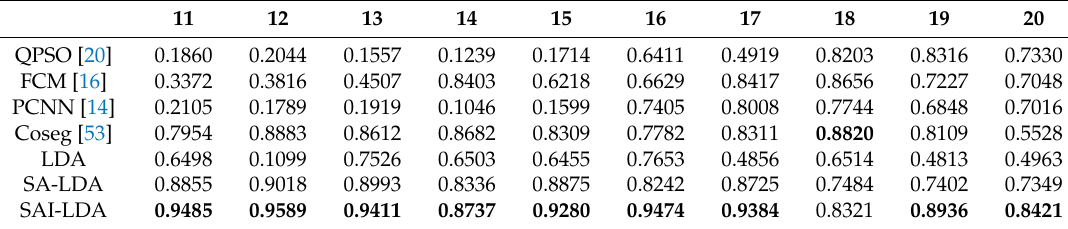
Table 2. Image segmenting accuracy (IA) of the comparative experiments. The methods below are quantum-behaved particle swarm optimization (QPSO), fuzzy c-means clustering (FCM), pulse coupled neural network based segmentation (PCNN), Co-segmentation, the traditional latent Dirichlet allocation (LDA), self-adaptive latent Dirichlet allocation (SA-LDA), and self-adaptive iterative latent Dirichlet allocation (SAI-LDA).